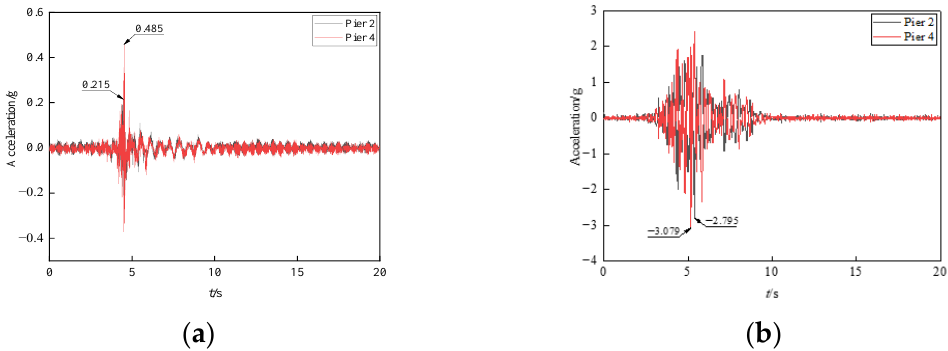
Figure 7. Acceleration response at the top of the piers. ( a ) X-direction ( b ) Y-direction.